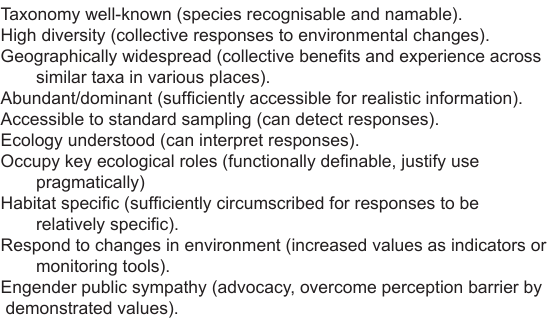
Table 3. Some criteria that may be useful to select invertebrate groups as priorities in conservation, as ‘tools’ in wider environmental assessment (variously as indicators, flagships, umbrella groups and keystones) (after New